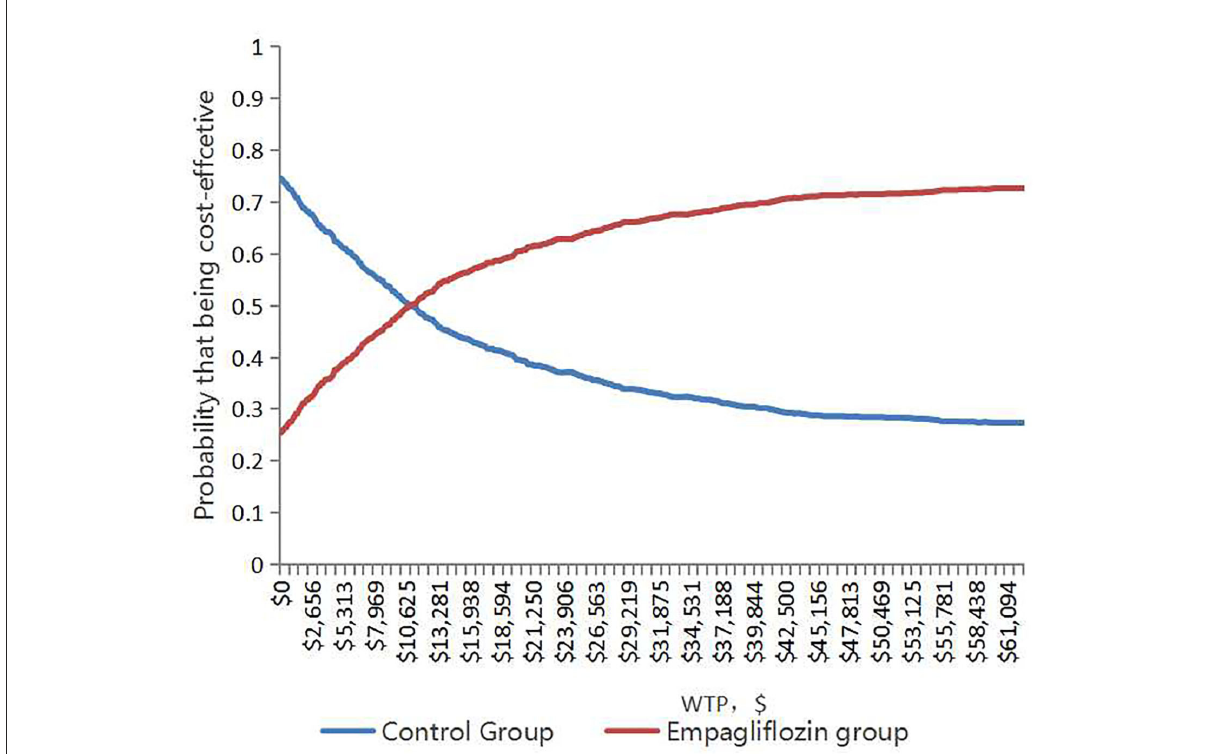
FIGURE4 The cost-effectiveness acceptability curve shows the maximum willingness to pay and the corresponding probability of cost-effectiveness for the Empagliflozin group and Control group.